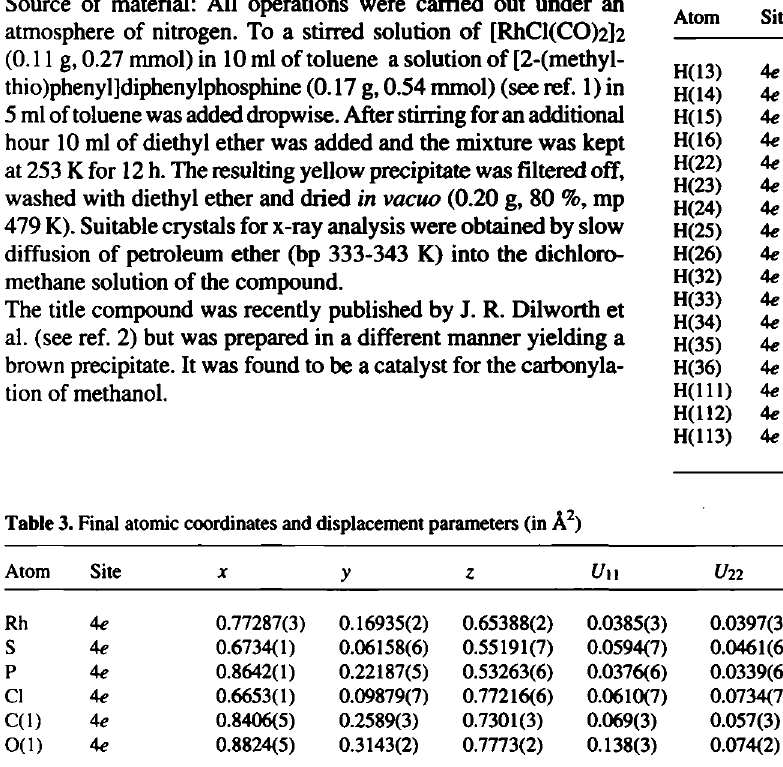
Table 2. Final atomic coordinates and displacement parameters (in Â 2 ) Atom